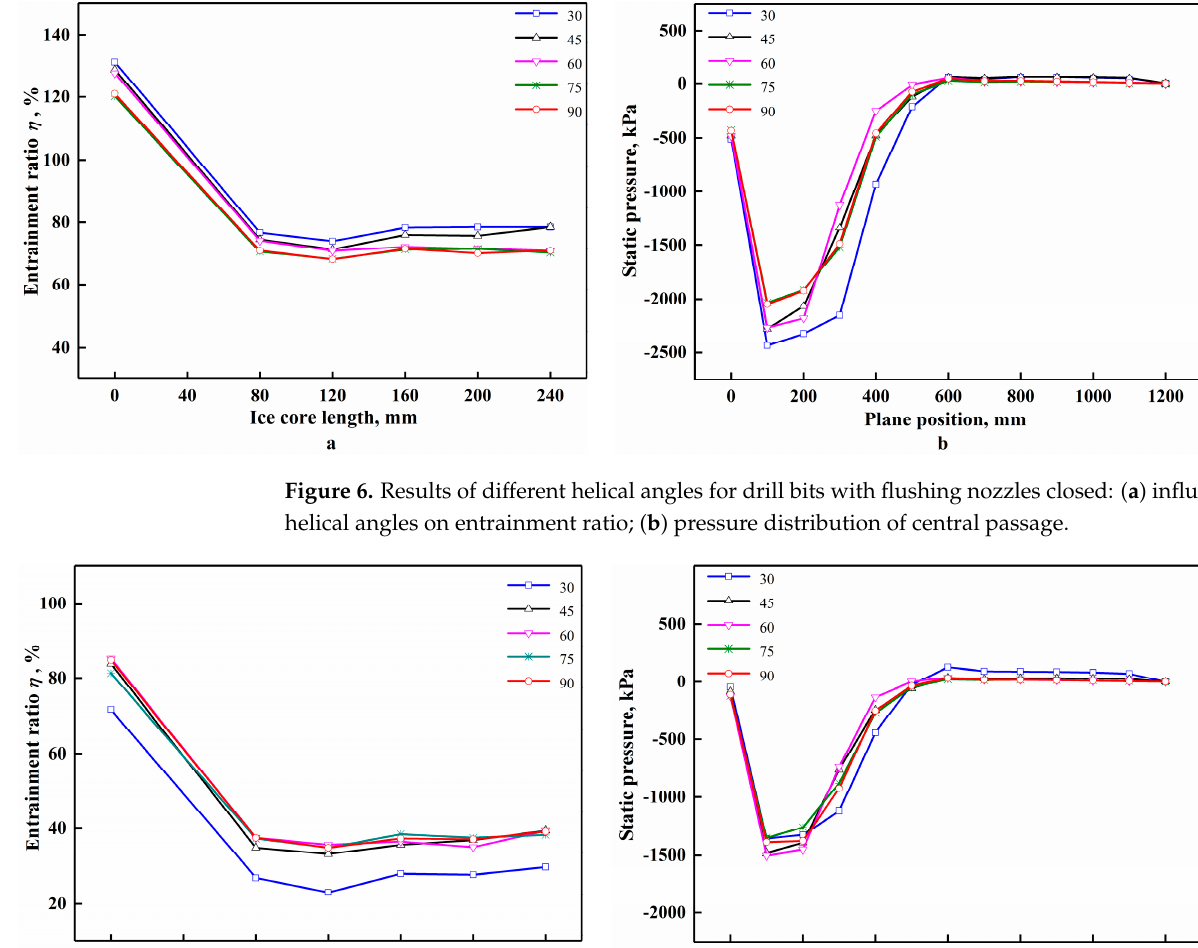
Figure 6. Results of different helical angles for drill bits with flushing nozzles closed: ( a ) influence of helical angles on entrainment ratio; ( b ) pressure distribution of central passage.